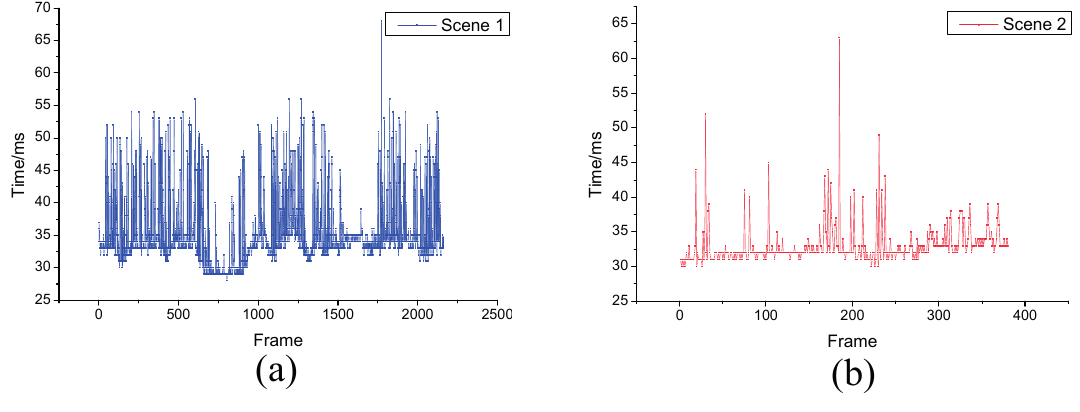
Figure 13. Real-time performances of the urban scene ( a ) and the rural scene ( b